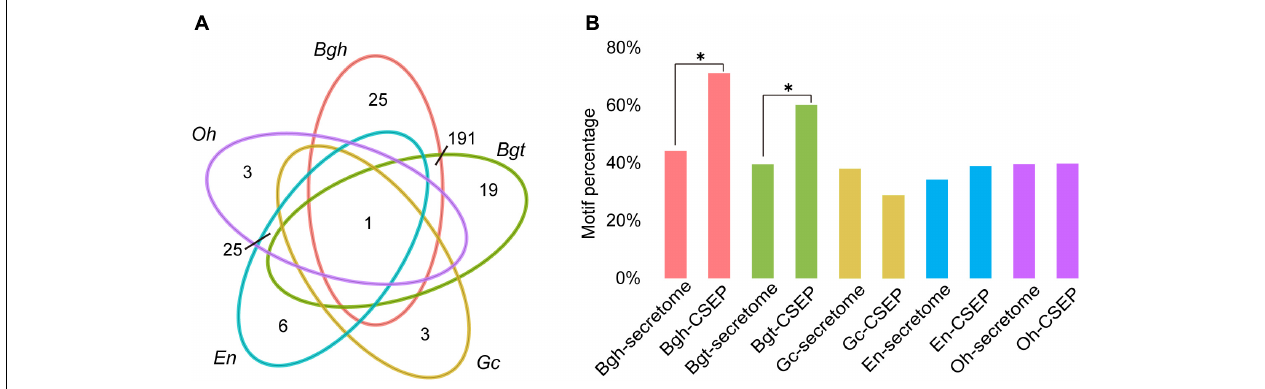
FIGURE 4 | Larger CSEP family sizes and more motifs in monocot powdery mildews compared to dicot powdery mildews. (A) Comparison of orthologous CSEP families among powdery mildews. Each number in the diagram represents the number of CSEP families within a group. (B) Percentage of [Y/F/W] × C motifs in powdery mildew CSEPs and secretomes except for CSEP. Asterisks indicate significant difference ( ∗ P < 0.05, Fisher’s exact